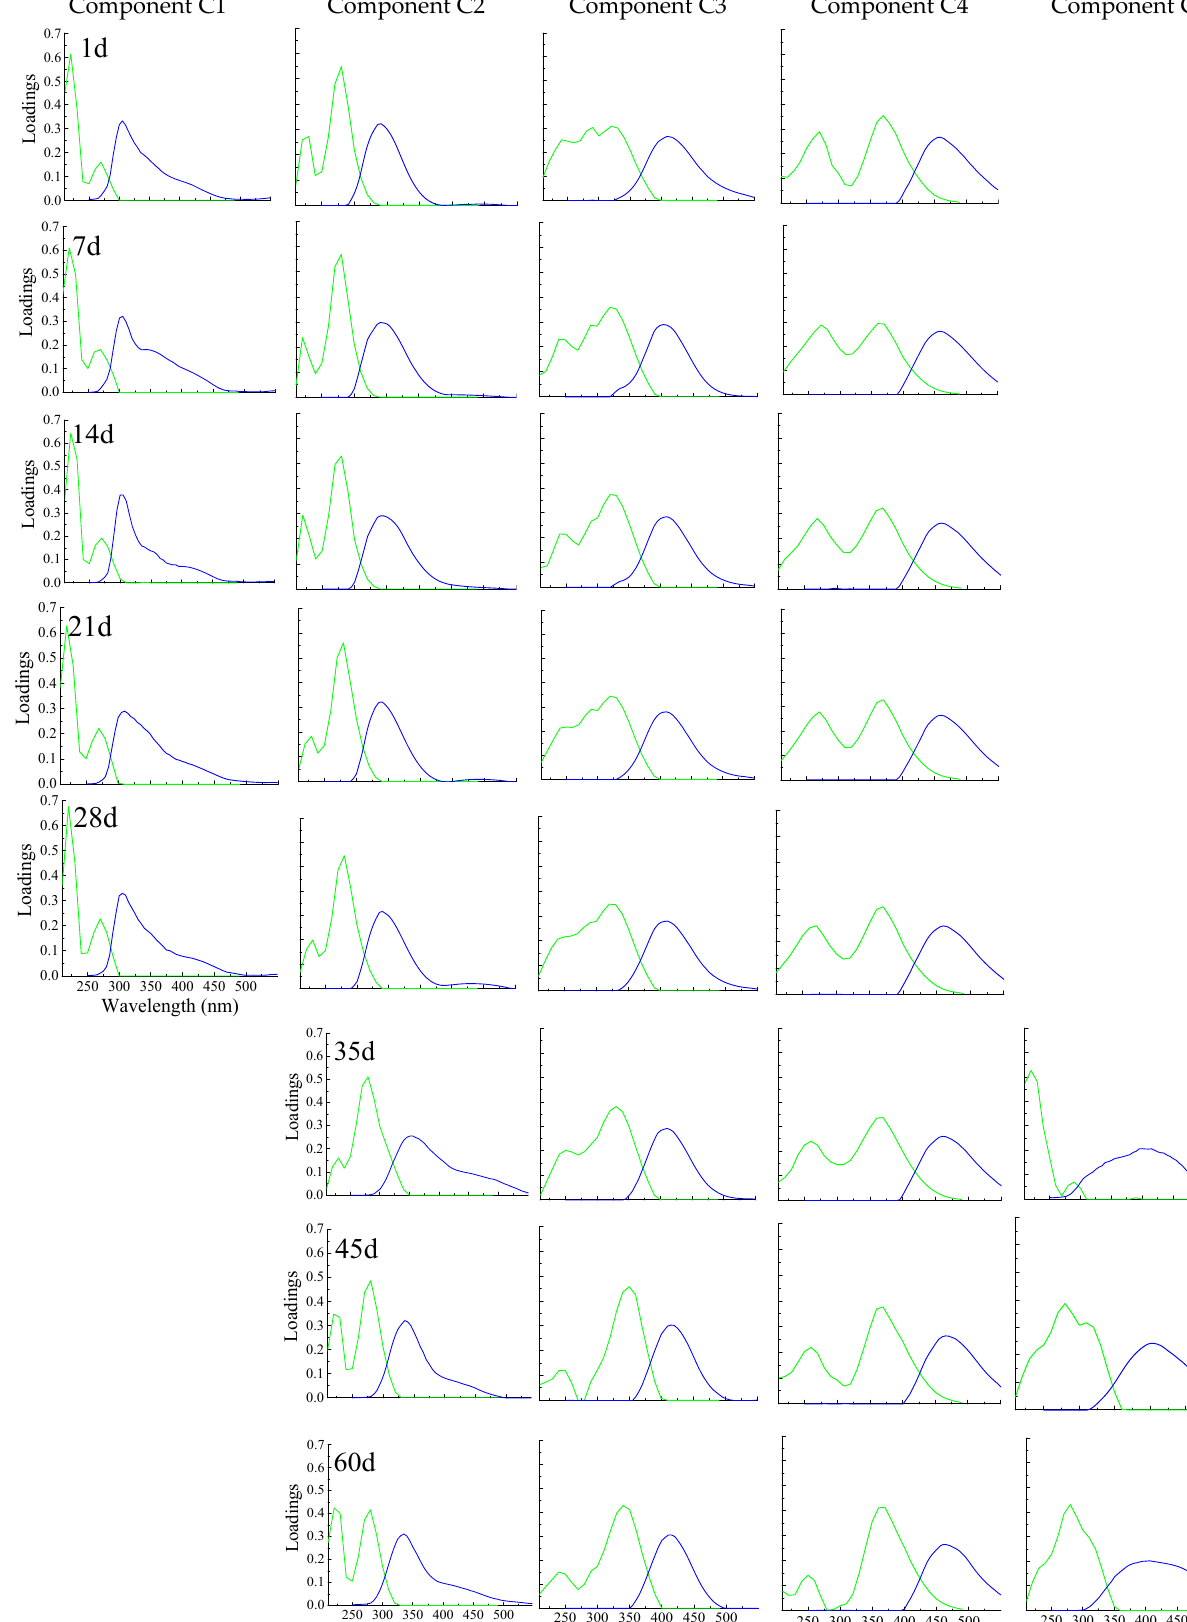
Figure 1. DOM PARAFAC components on composting days 1, 7, 14, 21, 28, 35, 45, and 60. The excitation wavelengths of the DOM components were plotted with blue lines, and the emission wavelengths of the DOM components were plotted with green lines. From composting days 1 to 28, components C1 to C4 were identified. From composting days 35 to 60, component C1 vanished with the observation of component C5.